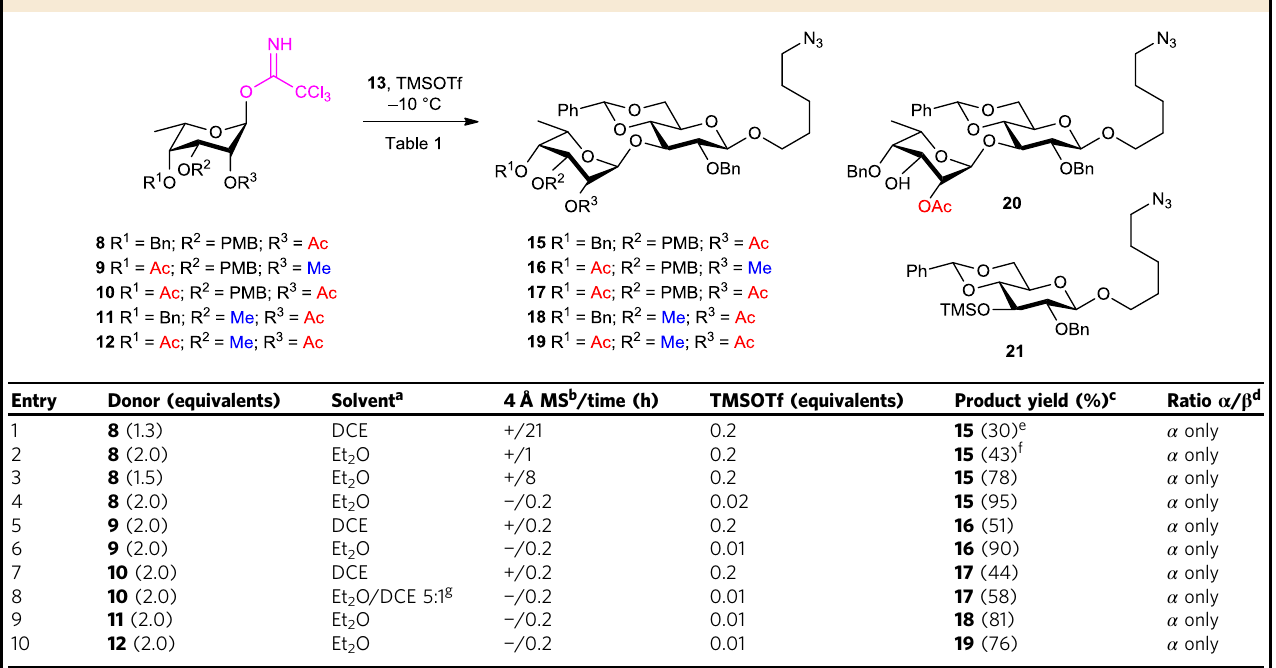
Table 1 Synthesis of protected